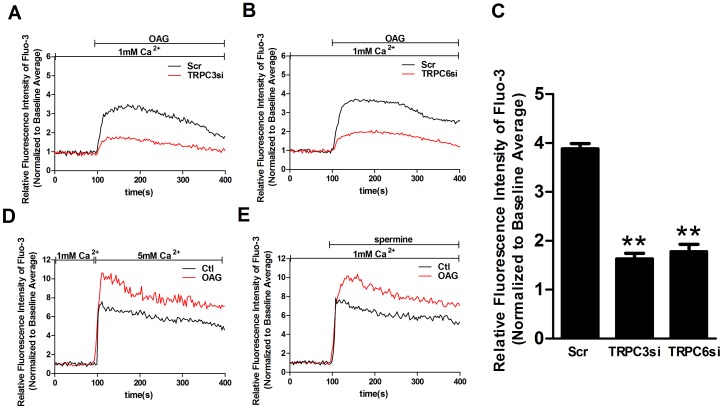
CaSR agonist-mediated Ca2+ entry is likely through receptor-operated Ca2+ channels in human MCs.[Ca2+]i dynamics were monitored by Fura-3 fluorescence methods. Representative traces are shown in A-D. (A, B) Representative traces (A–B) and summary of data (C) showing that transfection with TRPC3 siRNA (A) or TRPC6 siRNA (B) significantly reduces the 100 µM OAG-induced Ca2+ influx (p<0.01 vs. Scr, n = 4), respectively, compared with transfection with scrambled siRNA. Data are shown as the means ± SEMs. (D, E) The 5 mM [Ca2+]o(D)- and spermine(E)-induced [Ca2+]i increase is significantly enhanced by pretreatment with 100 µM OAG for 20 min (p<0.05 vs. Ctl, n = 4). The results were from at least three independent experiments, and each experiment measured 20 to 40 cells.